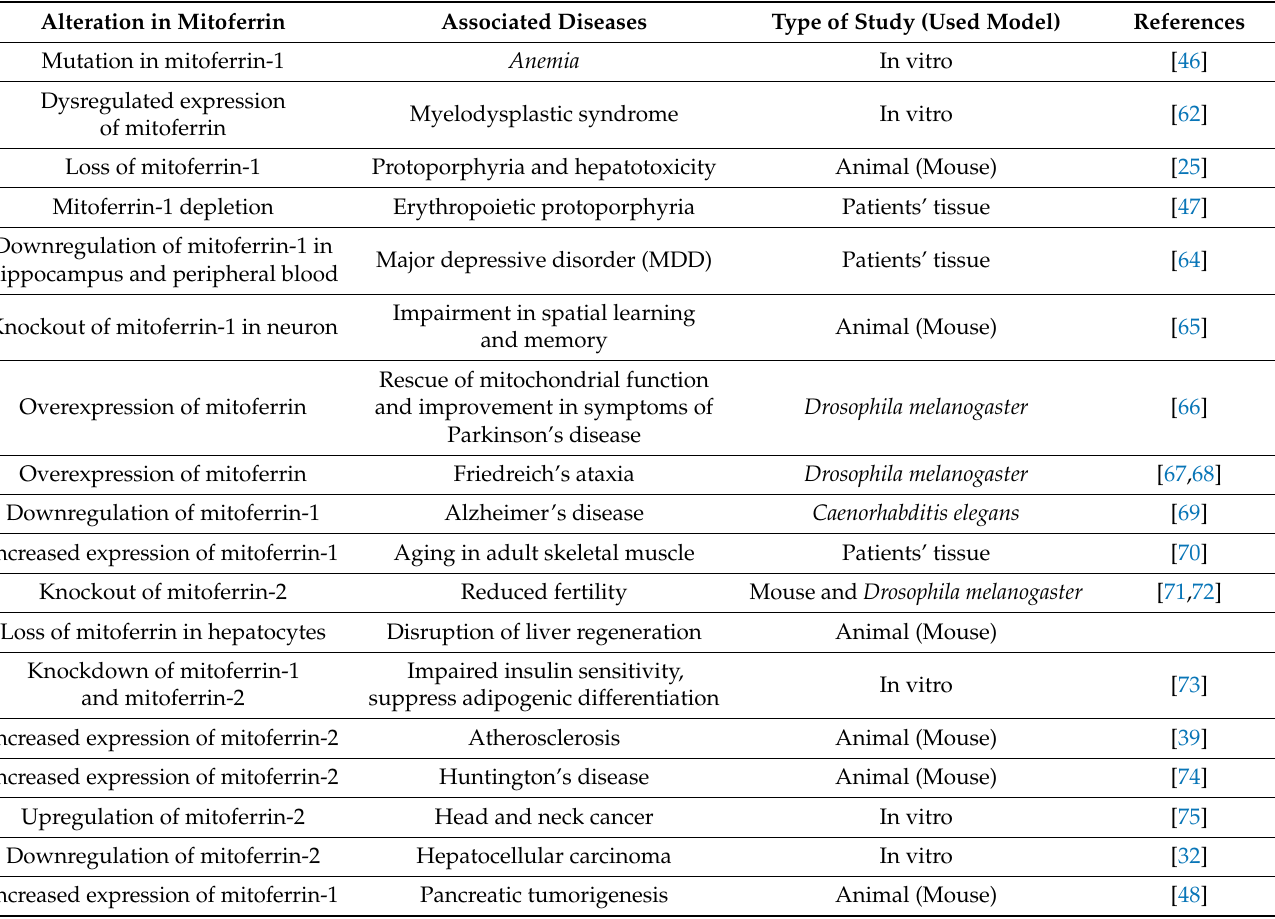
Table 3. Alteration of mitoferrin in different pathophysiological